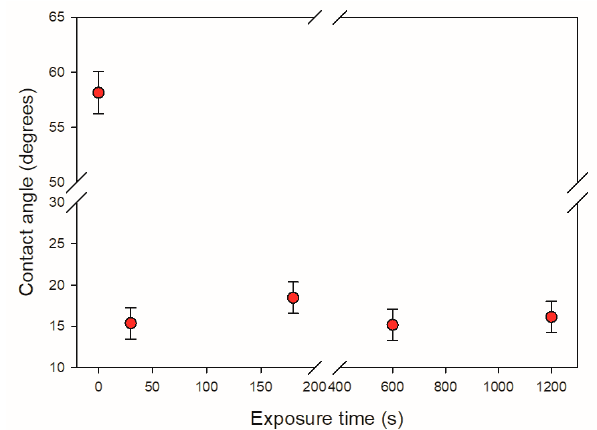
Figure 7. Effects of plasma treatment on the contact angles of water droplets on black spruce wood (averaged across radial and tangential longitudinal samples). Error bars represent ± standard error of difference derived from ANOVA ( p < 0.05).